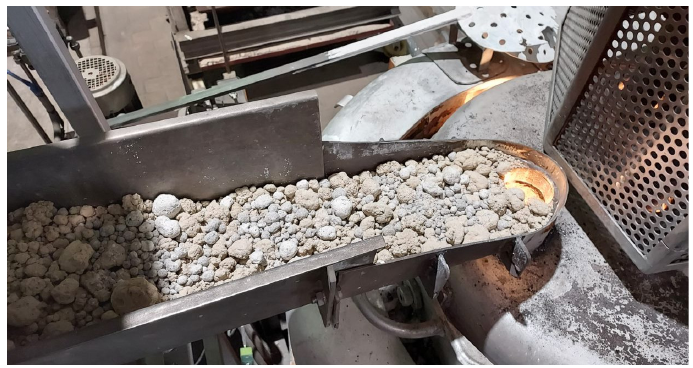
Figure 2. Feeding of the pelletized mixture to the furnace.